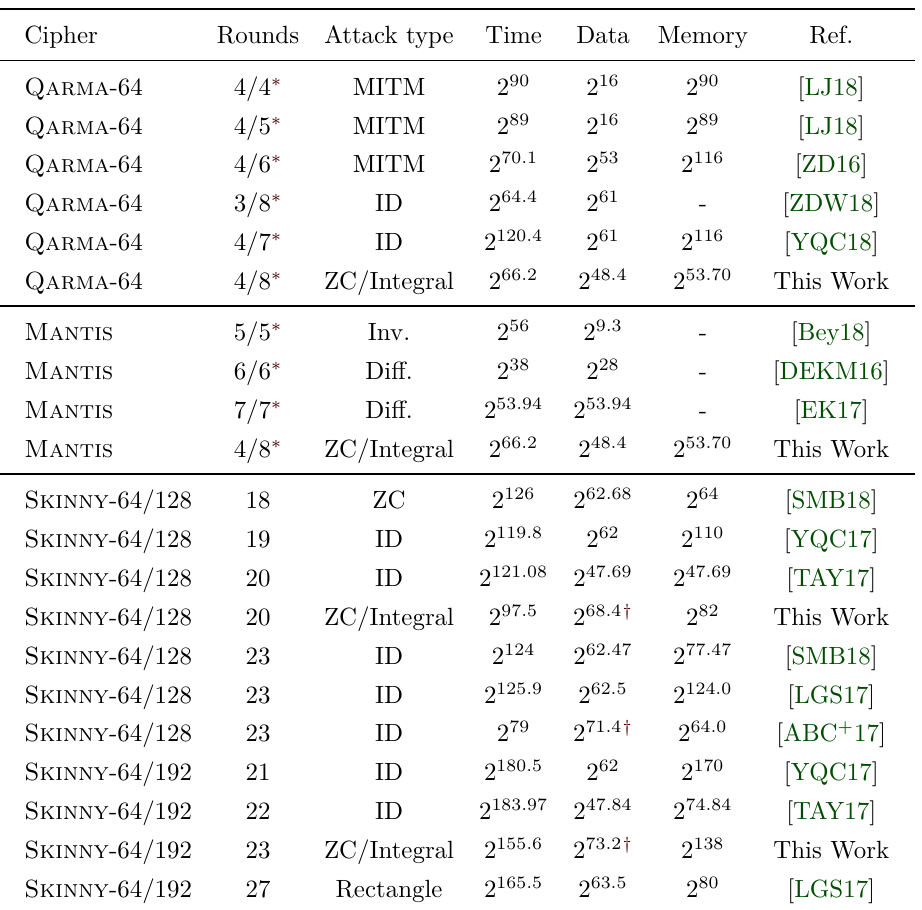
Table 1: Overview on previous and proposed key-recovery attacks on variants of Qarma -64, Man- tis , Skinny -64/128 , and Skinny -64/192. MITM/ID/ZC/Inv. = Meet-in-the-Middle/Impossible